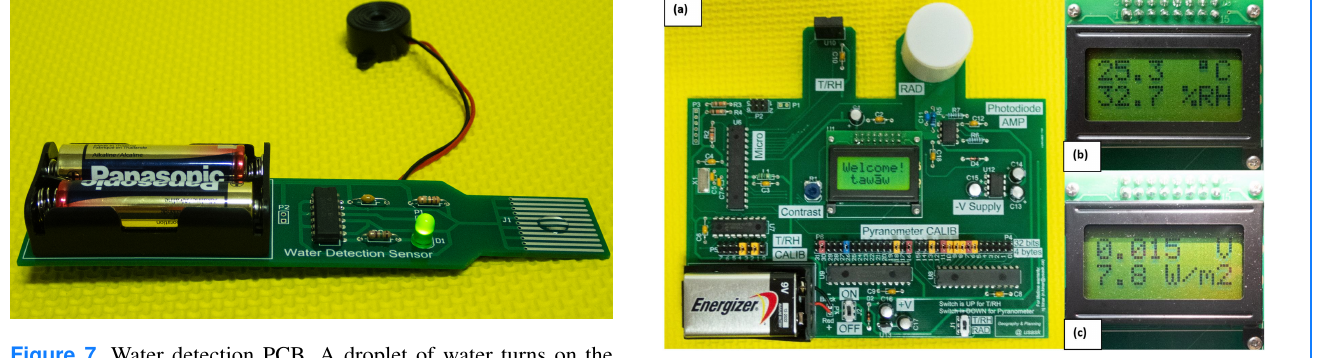
Figure 8. (a) Hybrid temperature, relative humidity (RH), and so- lar radiation sensor. (b) LCD display showing calibrated tempera- ture and relative humidity (RH) readout. (c) LCD display showing calibrated voltage output and radiation flux in Wm − 2 . Calibration coefficients are set using removable plastic jumpers and the position of each calibration header is indicated by “CALIB” marked on the PCB silkscreen. The “ T/ RH” marking indicates the position of the temperature and RH sensor, whereas the “RAD” marking indicates the position of the pyranometer sensor comprised of a photodiode and an op-amp. The photodiode is covered with a piece of plastic pipe and a circular Teflon diffuser. This ensures that the photodi- ode has a cosine response to obtain a hemispherical measurement. Other markings indicate the positions of various PCB sub-systems, including a switch for setting the mode of circuit operation and a contrast adjustment